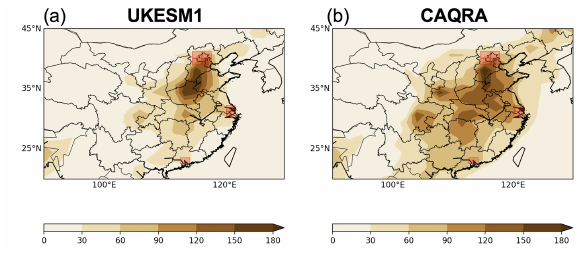
Figure 1. Spatial distributions of winter mean daily PM 2 . 5 concen- trations (µgm − 3 ) across China during JFD 2014 (a) simulated by UKESM1 and in (b) the CAQRA reanalysis. UKESM1 grid cells covering Beijing (four grid cells), Shanghai (two grid cells), and Guangzhou (one grid cell) are marked by red